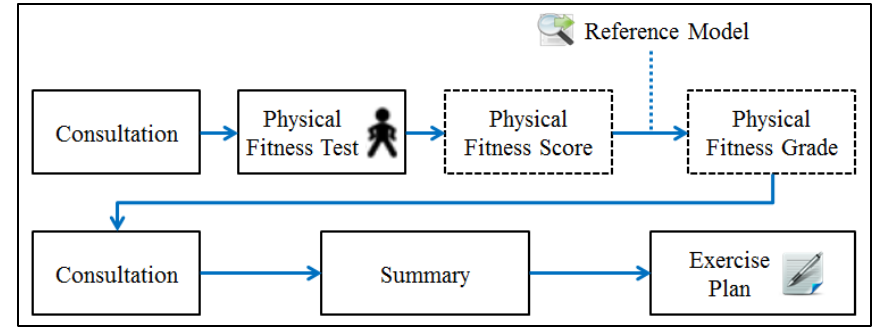
Figure 3. Workflow for generating an exercise plan based on a fitness